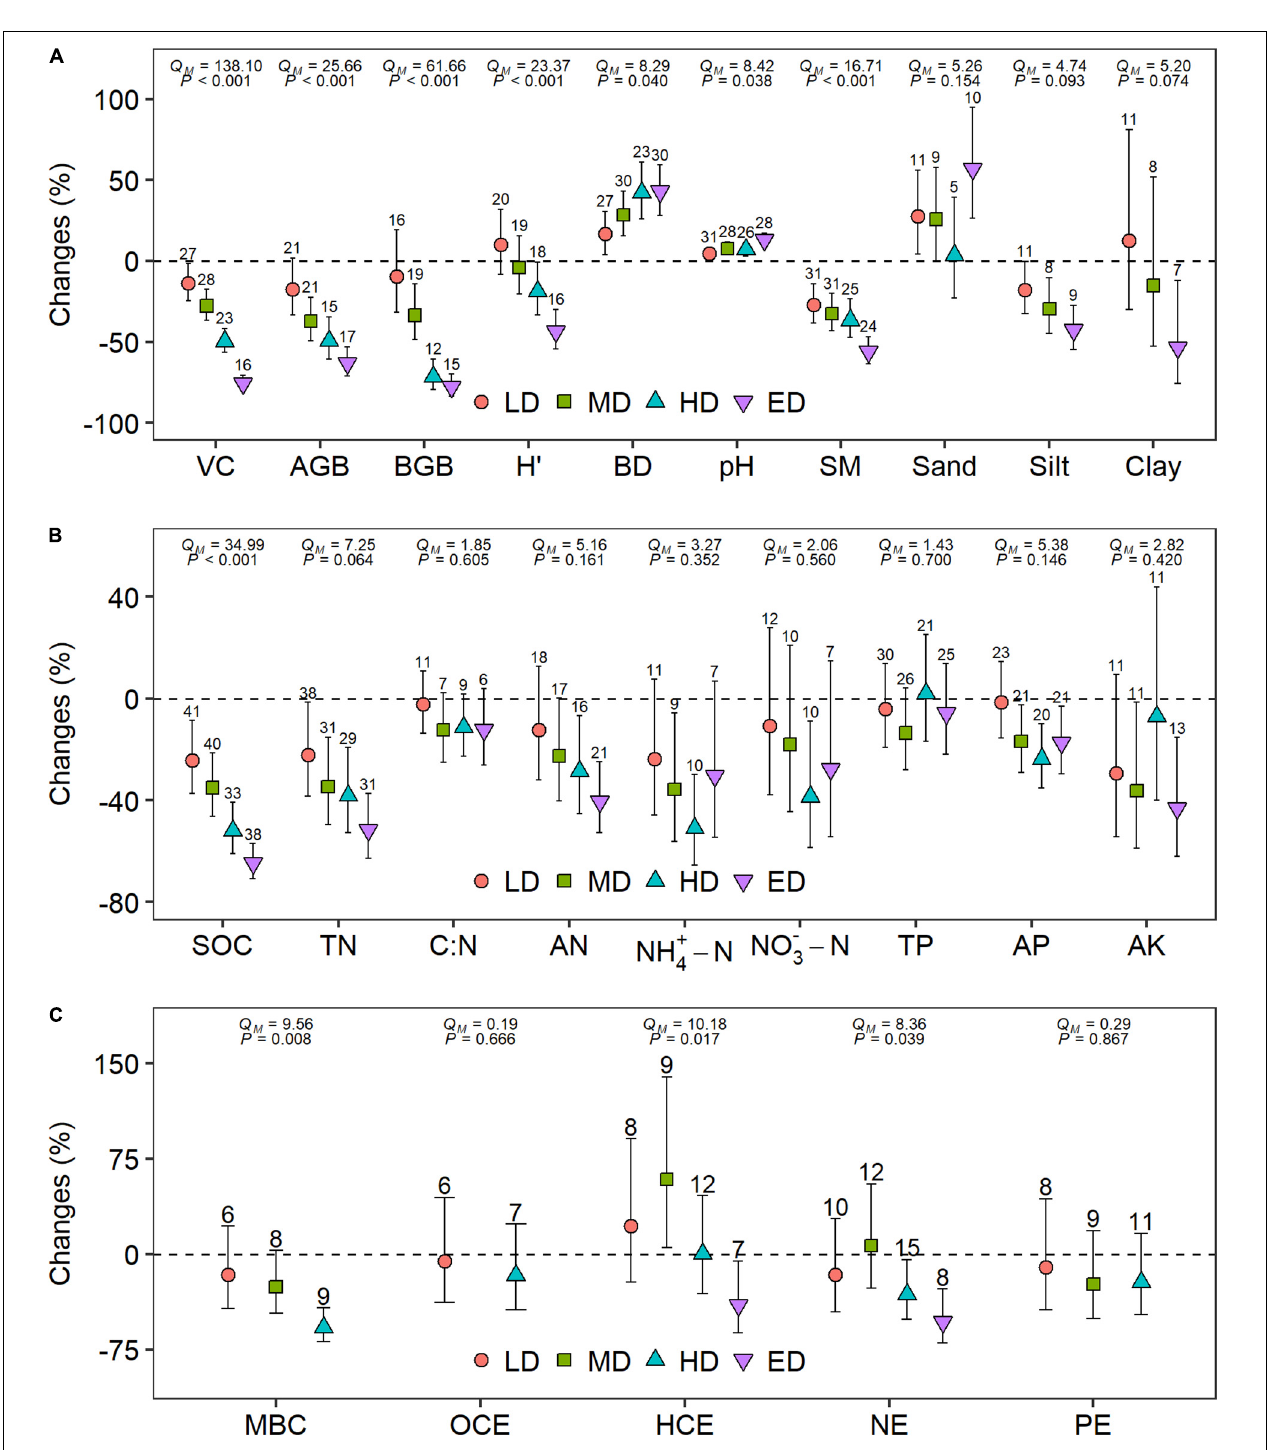
FIGURE 2 | Percent changes of (A) plant and six soil property variables, (B) soil nutrient variables, and (C) microbial variables after grassland degradation across different degradation stages. Weighted means and their 95% CIs of percent changes are given. The numbers at the top of the CIs represent the sample sizes. The significances of degradation stages are tested by the omnibus test (QM). LD, light degradation; MD, moderate degradation; HD, heavy degradation; ED, extreme degradation; VC, vegetation cover; AGB, aboveground biomass; BGB, belowground biomass; H’, Shannon-Wiener index; BD, soil bulk density; SM, soil moisture; SOC, soil organic carbon (C); TN, total nitrogen (N); AN, available N; NH 4 -N, ammonium N; NO − 3 -N, nitrate N; TP, total phosphorus (P); AP, available P; AK, available potassium; MBC, microbial biomass C; OCE, oxidative C-cycling enzymes; HCE, hydrolytic C-cycling enzymes; NE, N-cycling enzymes; PE, P-cycling enzymes. Source data are provided as a Source Data